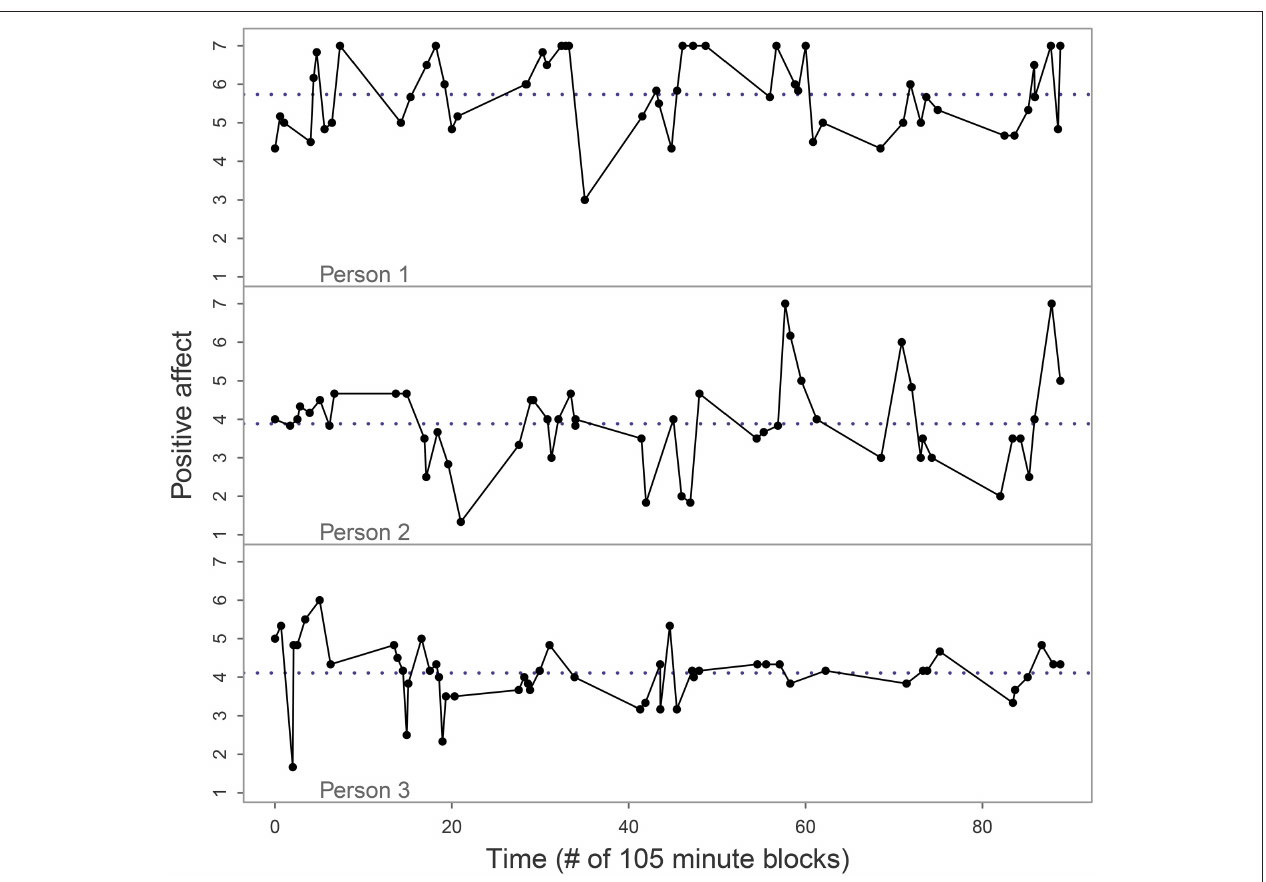
FIGURE 8 | Positive affect data for the three adolescents in our empirical analysis. The dots indicate the observations and reveal that they were spaced irregularly, sometimes following each other quickly. Note that the software recorded the times that the questionnaires were filled out (thus matching the affect that the respondent reported), not the times of the beeps. The dotted line represents the person’s mean of